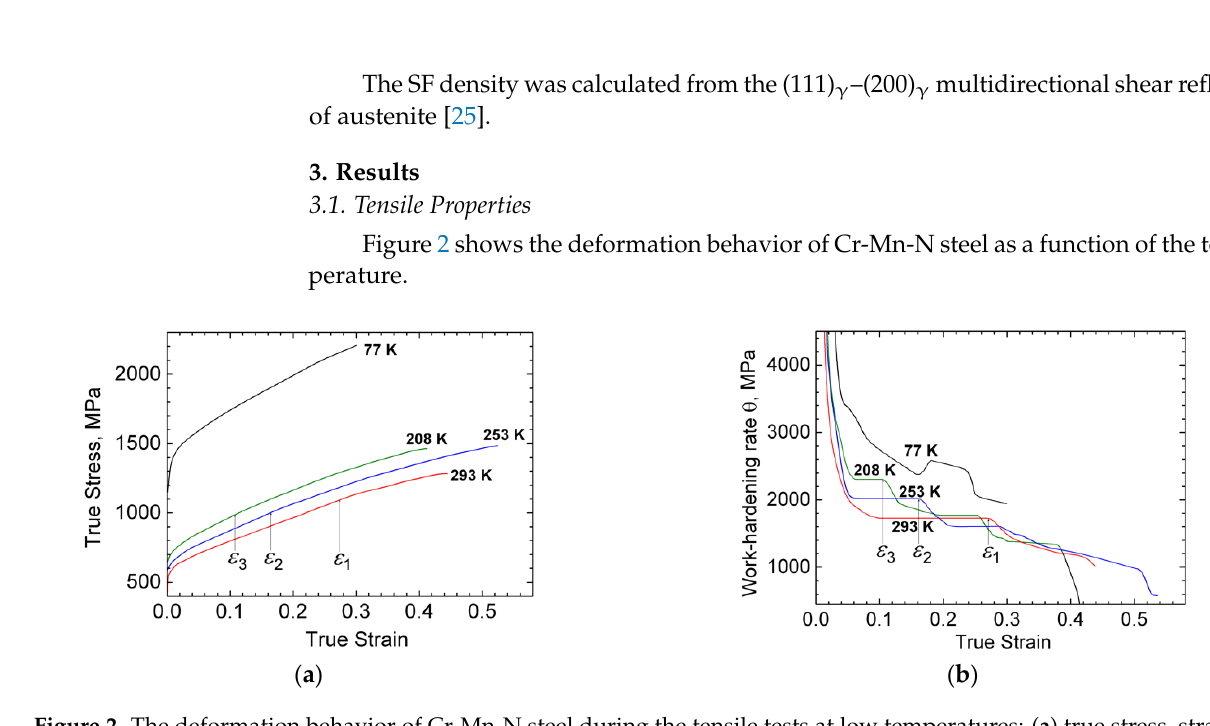
Figure 2. The deformation behavior of Cr-Mn-N steel during the tensile tests at low temperatures: ( a ) true stress–strain curves, ( b ) the θ = d σ /d ε work hardening rate.